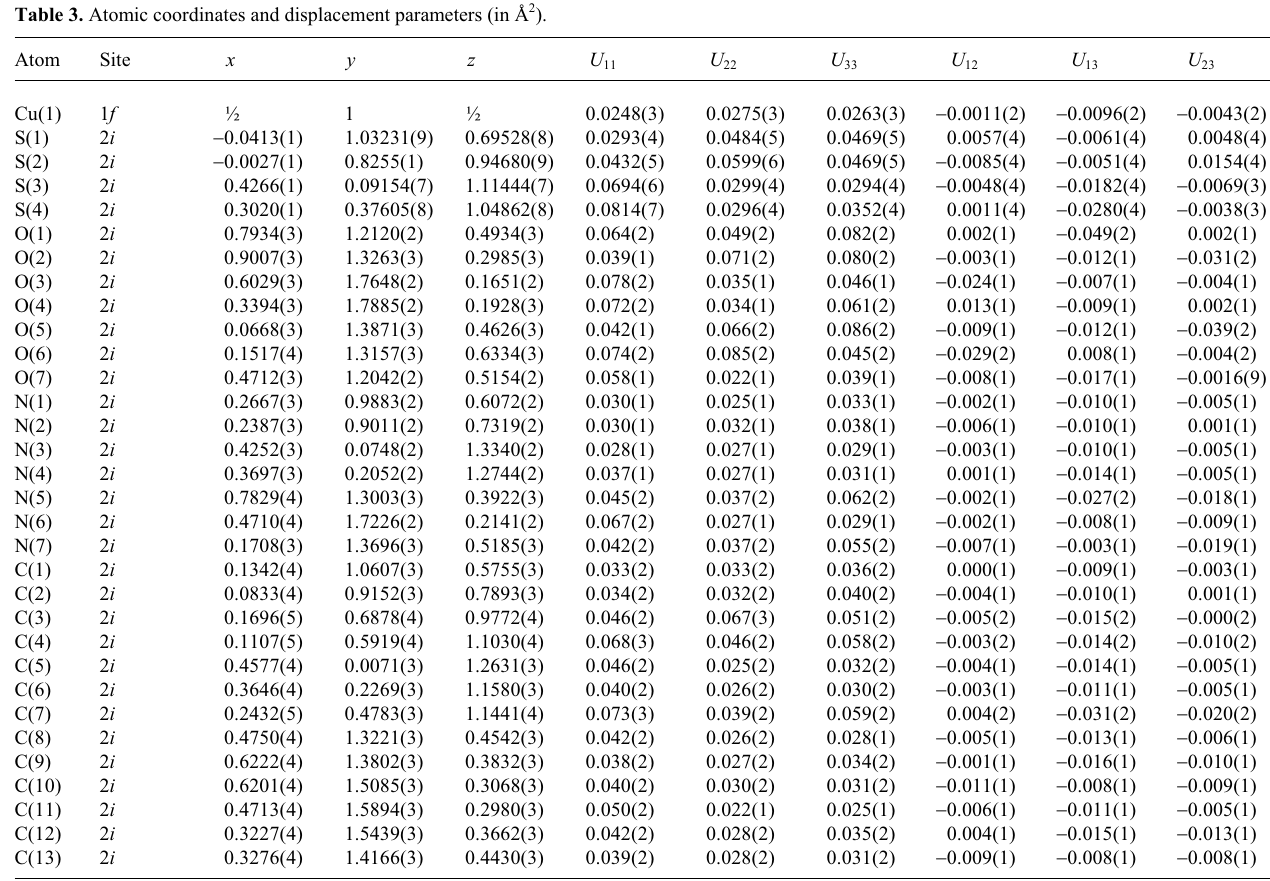
Table 3. Atomic coordinates and displacement parameters (in Å 2 ).